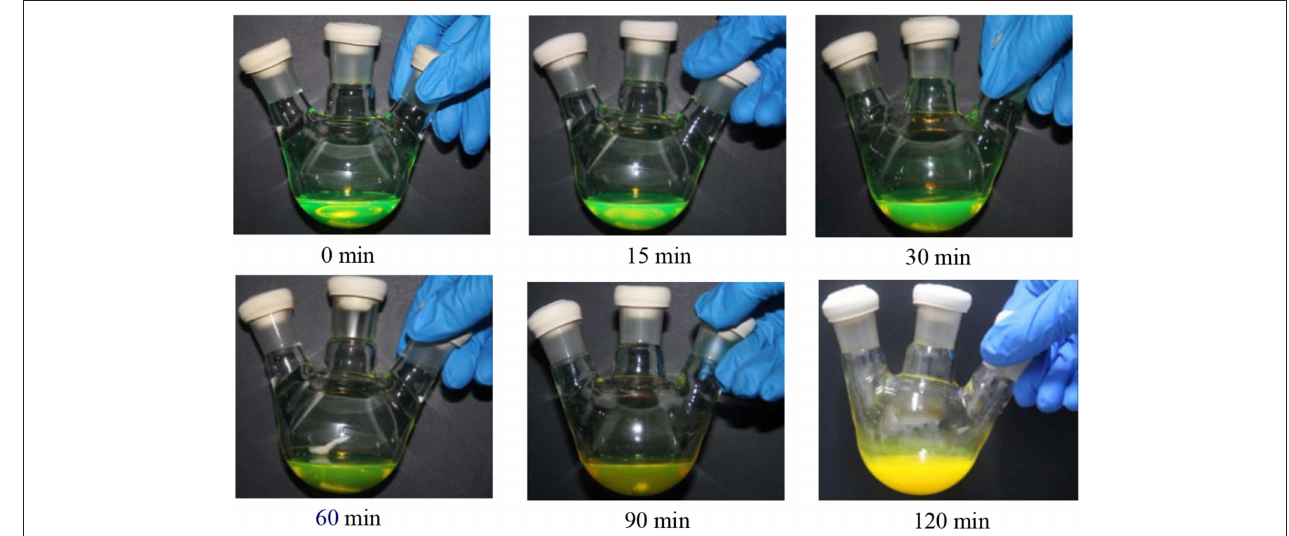
FIGURE 1 | Photographs of CsPbBr 3 NCs and BPO oxidized CsPbBr 3 NCs at different